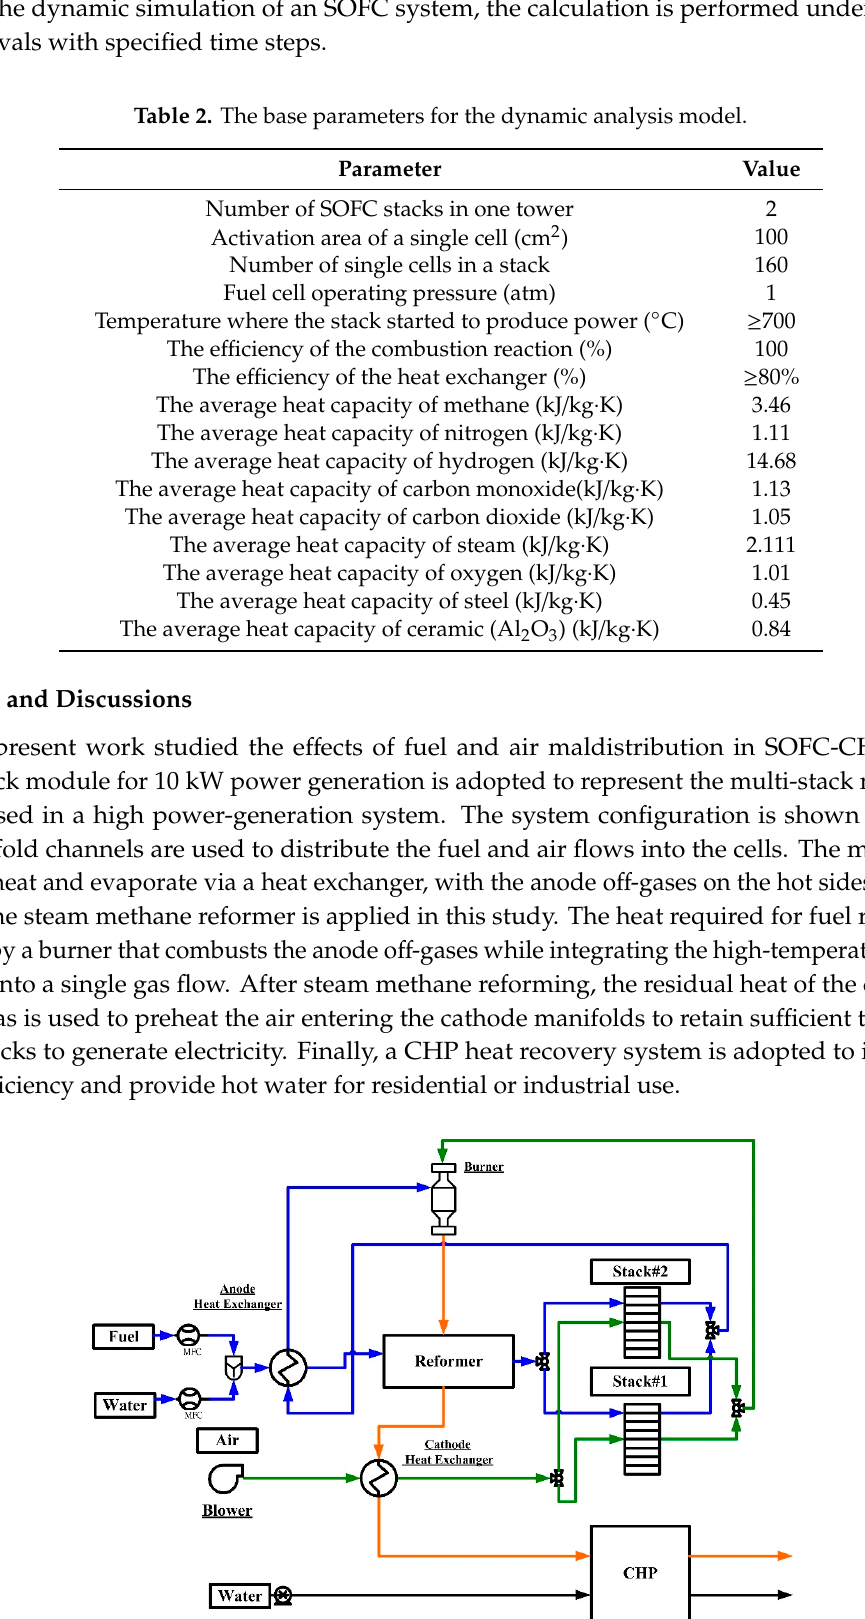
Figure 1. The solid oxide fuel cell (SOFC) system with a two-sub-stack module. CHP, combined heat, and power. and